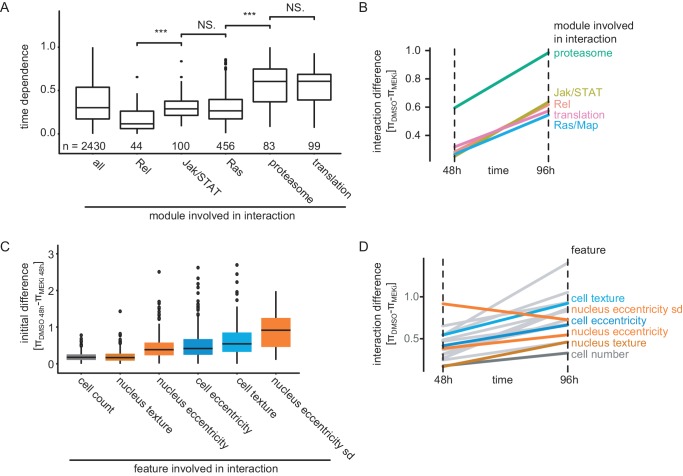
Timing and initial difference of interactions depend on the biological process and feature.(A) Time dependence (σ) of interactions stratified by biological process. Boxplots show the median (black bar), the 25th and 75th percentile (box) ±1.5 times the interquartile range (whiskers). Points outside that range are plotted individually. Significance is tested by a two-sided welch t-test (***: p<<0.001, NS: p>0.05). Data is shown based on significant (FDR < 0.1) cell-count-based interactions involving genes belonging to this process. (B) Median π-score differences stratified by pathway annotation of affected genes. All significant (FDR < 0.1) time-dependent interactions based on cell count feature are summarized by median. Interactions formed by genes that are proteasome associated show the highest initial difference and steepest increase over time. (C) Initial difference of interaction scores 48 hr after treatment stratified by feature. Boxplots show the median (black bar), the 25th and 75th percentile (box) ±1.5 times the interquartile range (whiskers). Points outside that range are plotted individually. All features (except nucleus texture) show significantly (p<<0.001, two-sided student’s t-test) higher initial differences than cell count based interactions. (D) Median π-score differences for the first and the last measured time point. Trajectories for all features are shown over all genes that showed a significantly time-dependent interaction (FDR < 0.1). Features are highlighted by their feature group. All features except nucleus eccentricity measure interaction differences that become more profound over time.